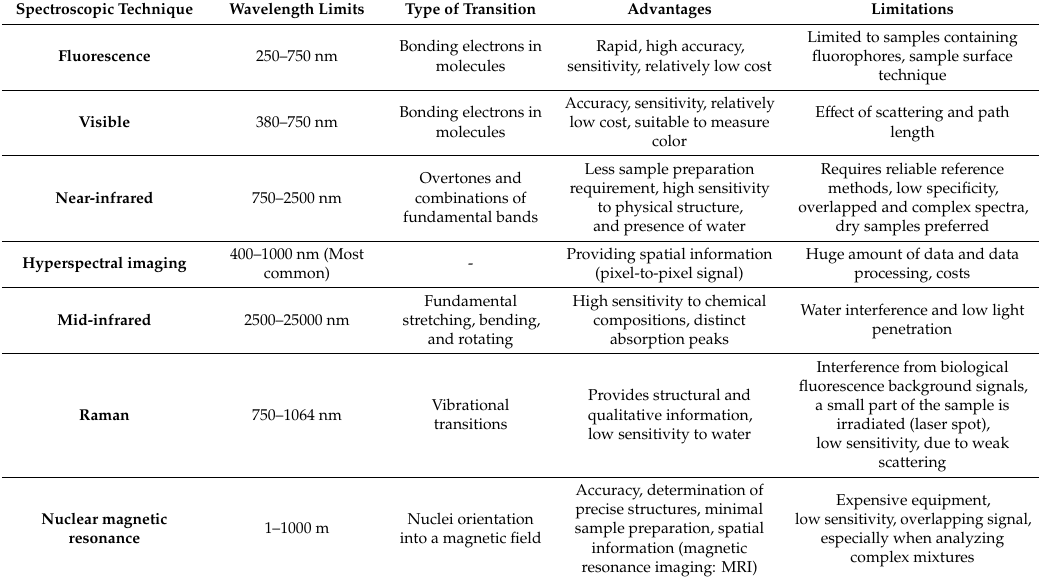
Table 3. The main characteristics of spectroscopic